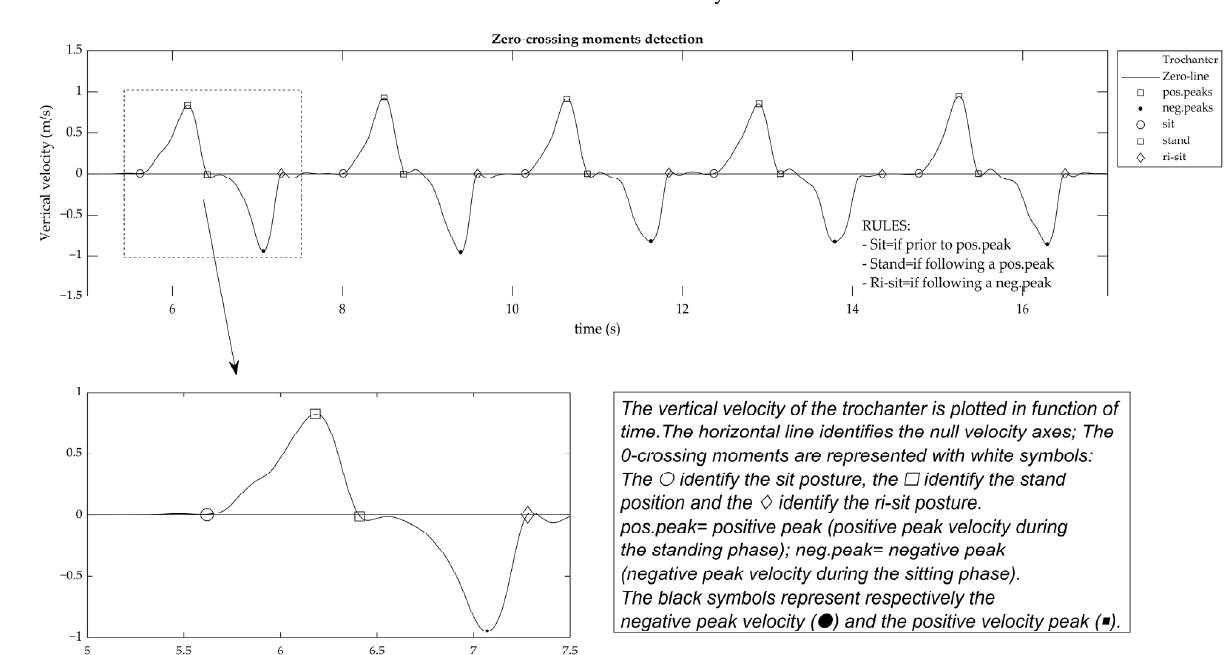
Figure 2. Example of vertical velocity profile during a 5STS Test as a function of time.